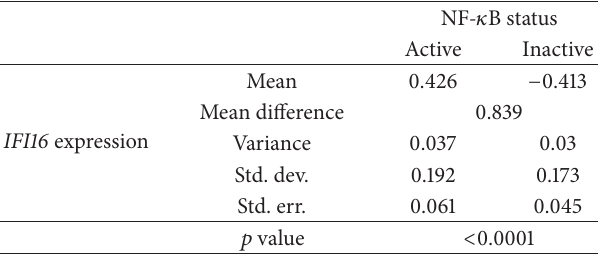
Table 3: IFI16 expression according to NF- 𝜅 B activation